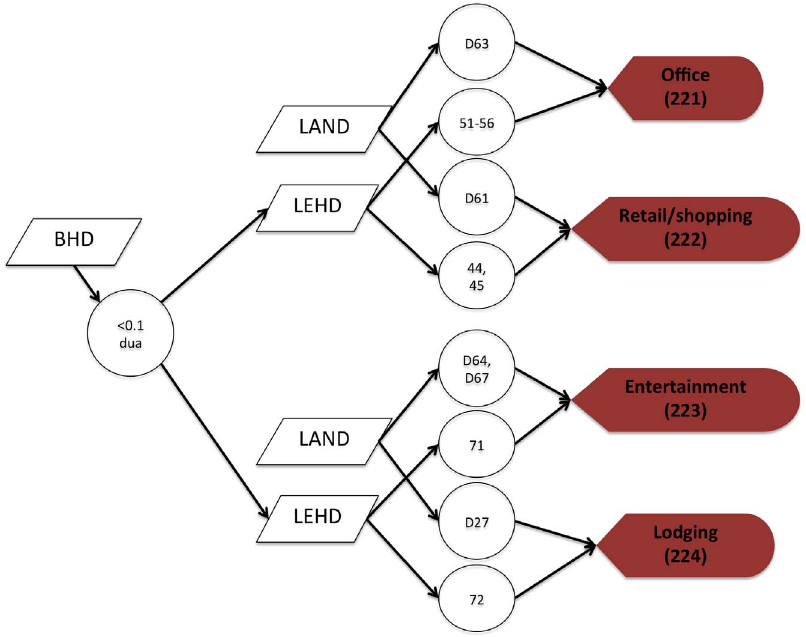
Figure 2. A flow chart depicting the process to map commercial land uses. Locations mapped as office commercial use were defined as an office building or office park by a census landmark polygon (LAND) or by North American Industry Classification System 2012 (NAICS) 2-digit code 51– 56, which includes information, finance and insurance, real estate, professional, scientific and technical services, management of companies, and administrative and support services. Because commercial and residential uses are often mixed (e.g. particularly vertically, with commercial on the ground floor and residential above), and because the Longitudinal Employer-Household Dynamics (LEHD) data are mapped at the Census block-level, the residential housing density also had to be low ( , 0.1 dua). Consequently, areas that are mapped as urban residential land use could also contain some commercial land uses as well. doi:10.1371/journal.pone.0094628.g002 PLOS ONE | www.plosone.org